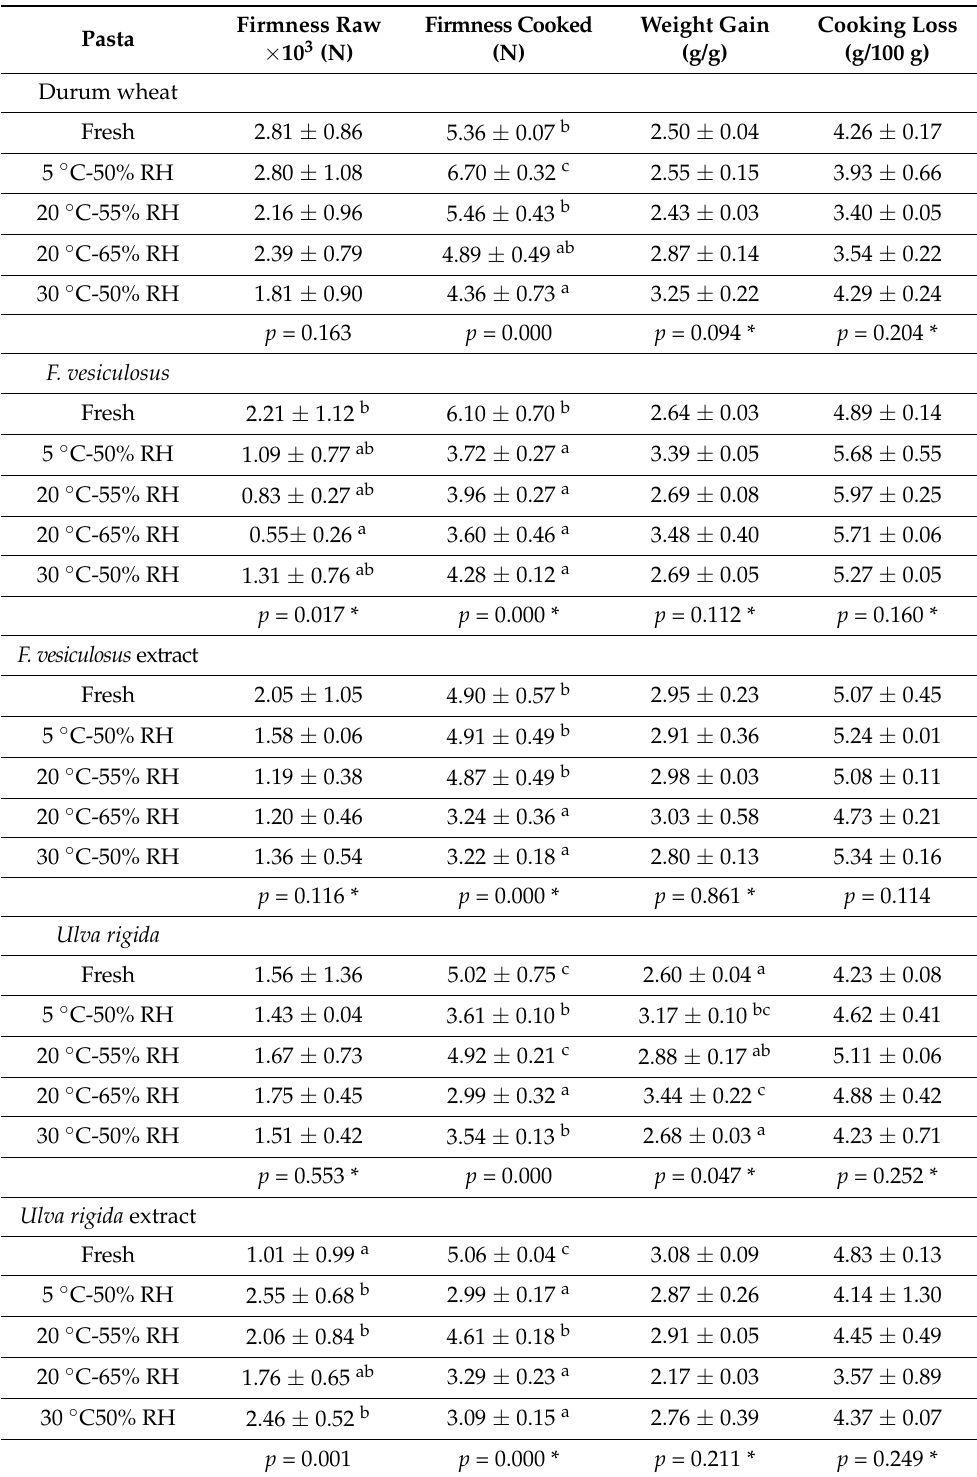
Table 2. Physicochemical parameters of pastas after preparation (fresh) and after storage for 6 months at four environmental